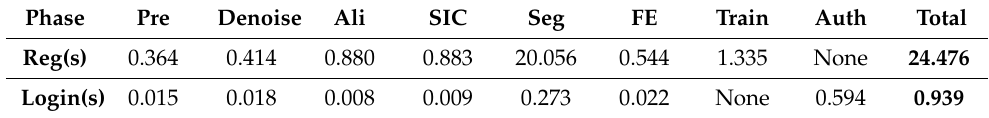
Figure 17. Resistance capability to impersonate attack (The red plus signs indicate outliers). Table 1. Average Time Efficiency.